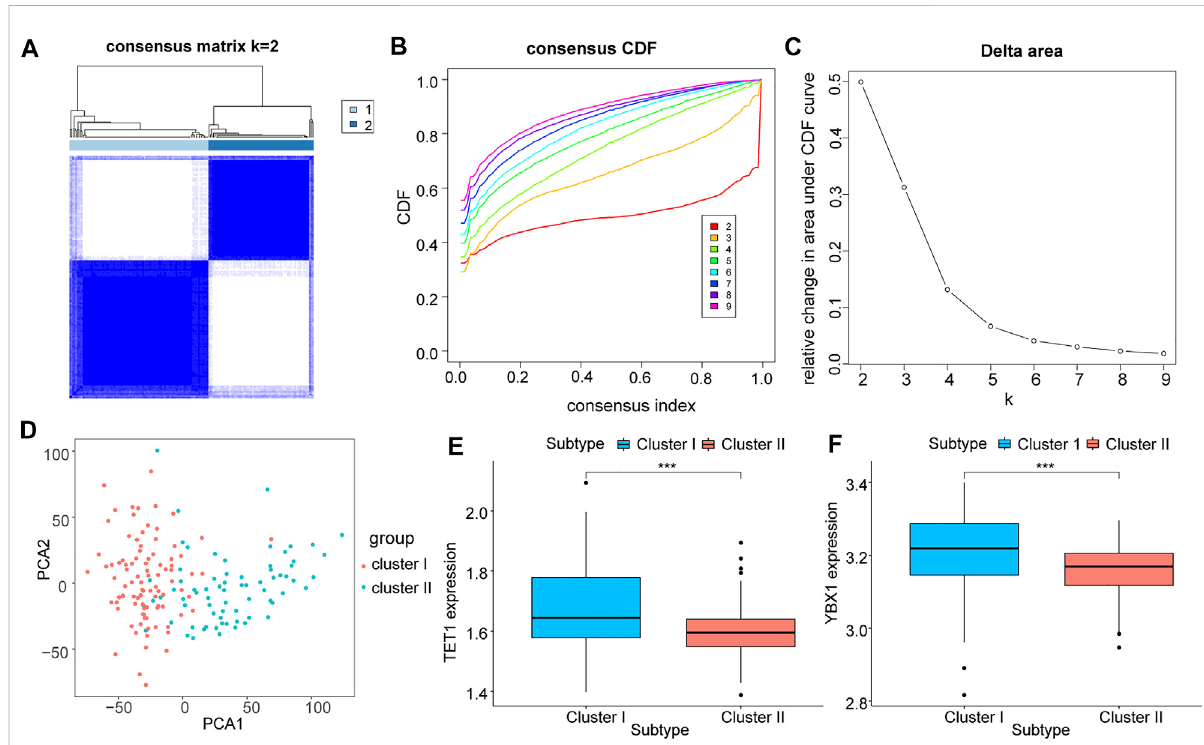
FIGURE 5 Correlation analysis of m5C regulatory genes with molecular subtypes of GEO liver cancer. (A-C) : All samples of GEO were classi fi ed by the expression level of m5C regulator genes; (D) : PCA analysis under different groupings; (E,F) : differential expression of key m5C regulator genes TET1 (E) and YBX1 (F) in different groupings, where cluster I is in blue and cluster II is in